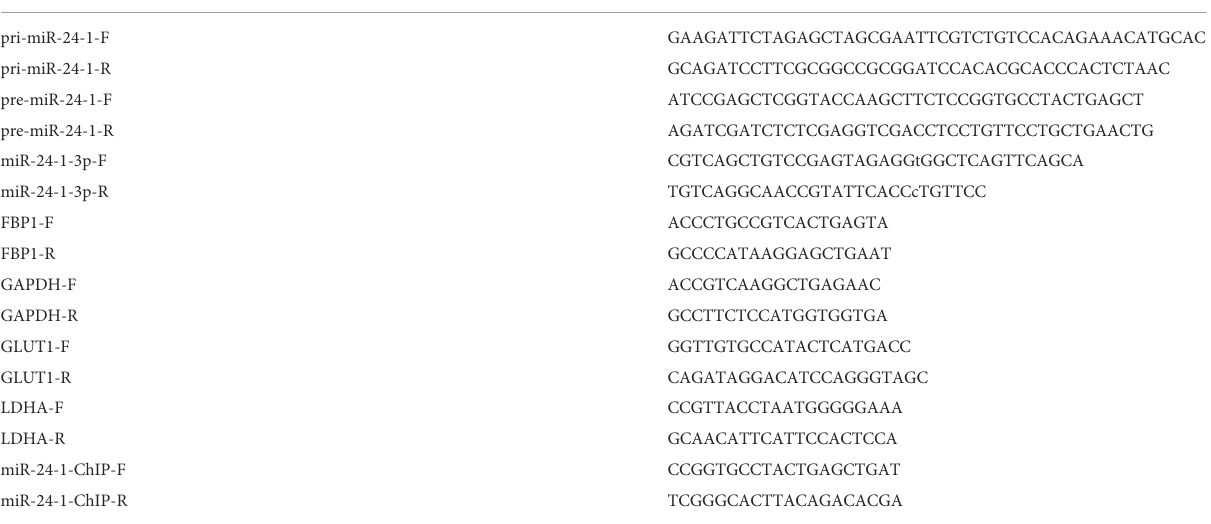
TABLE 1 The primer sequences used for plasmids construction, RT-PCR and ChIP-qPCR assays. Primer